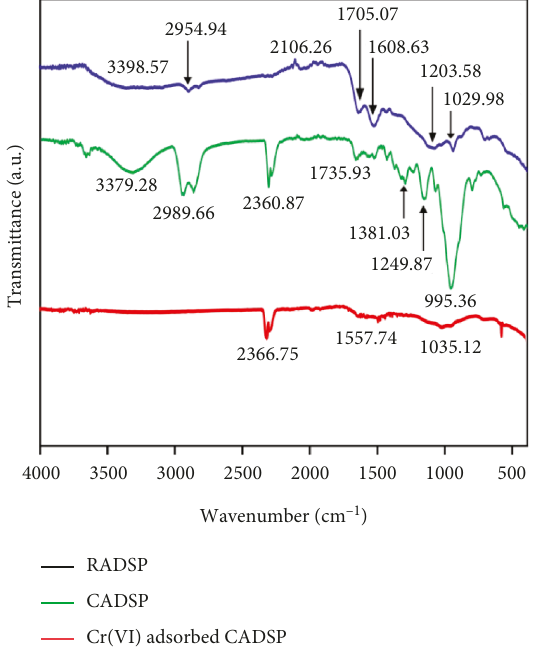
Figure 2: FTIR spectrum of RADSP and CADSP.